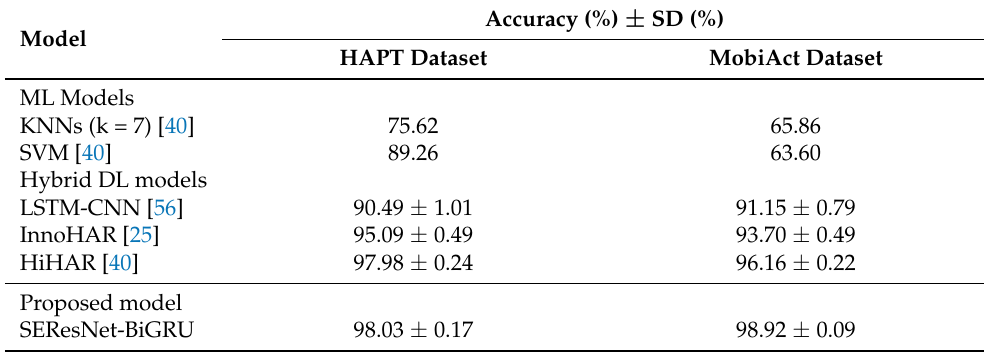
Table 7. Comparison results of the proposed model and previous